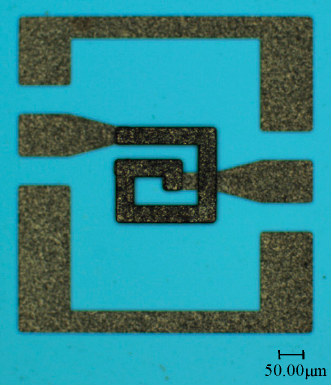
Figure 6. Photo of the MEMS suspended inductor.